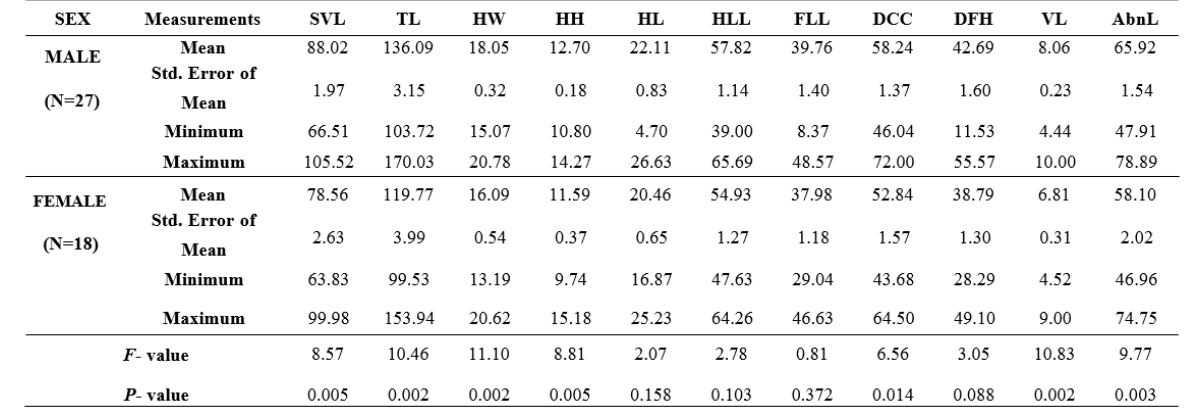
F IGURE 4 . (A), Dorsal view of a male (right) and a female (left) of Trapelus r. ruderatus ; (B), habitat and the color pattern of an adult male of Trapelus r. ruderatus . T ABLE 2. Descriptive analysis and independent ANOVA of metric characters in male and female specimens of Trapelus r. ruderatus